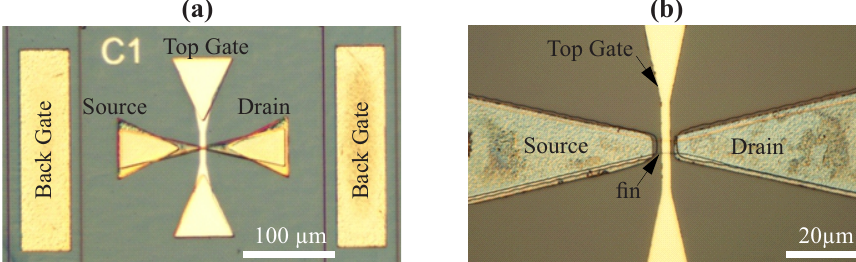
Figure 2. Optical microscope images of the fabricated FinHEMTs with back gate ( a ) and image of the active regions ( b ), channel width W Ch = 5 µm and gate length L TG = 2